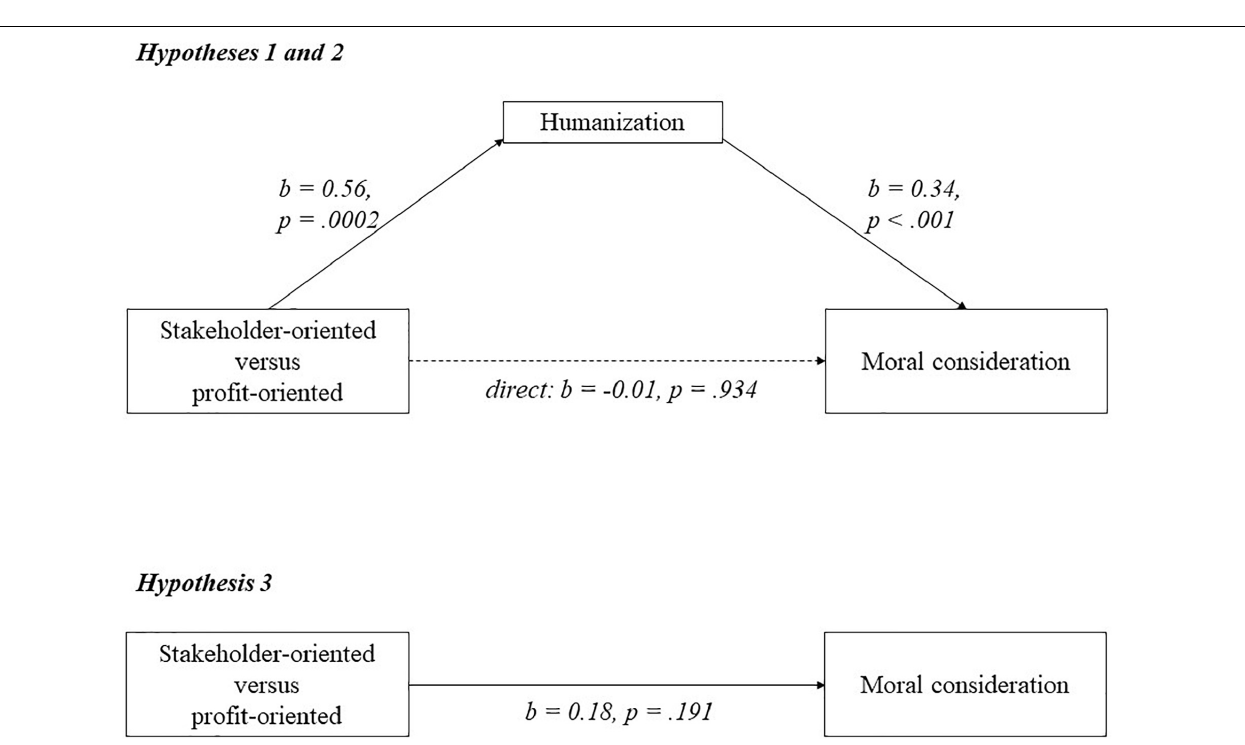
Frontiers in Psychology |